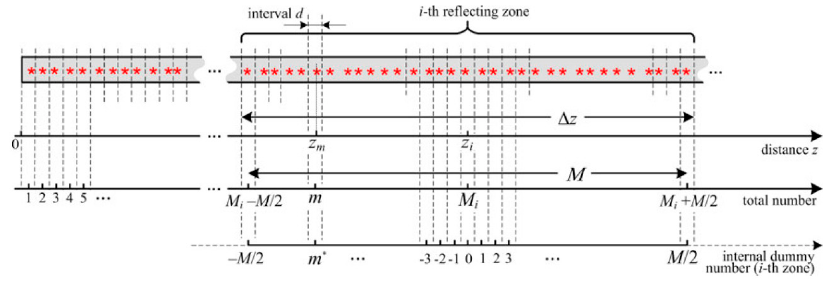
Figure 3. Rayleigh scattering model of the single ‐ mode optical fiber [26].